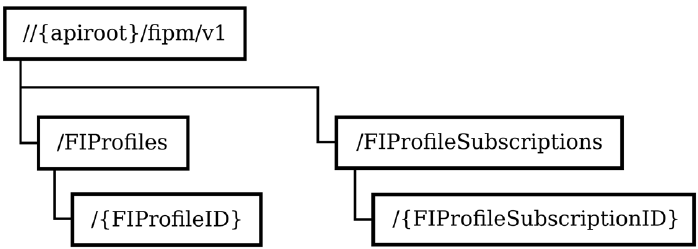
Figure 2. Structure of the URIs of the FIPM service resources. The FIProfiles resource is a container for the functional identity profiles. It supports the GET method, which retrieves the list of functional identity profiles. An individual functional identity profile is represented by the {FIPprofileID} resource and the GET method retrieves information about the specific functional